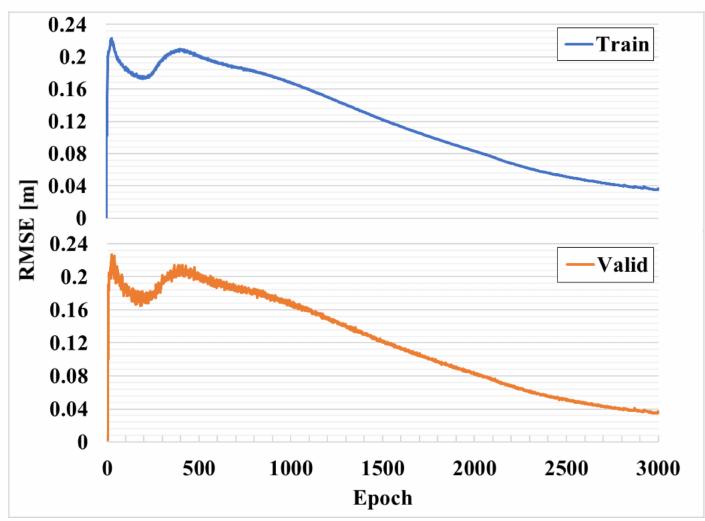
Figure 8. RMSE corresponding to learning of compensation network for 3000